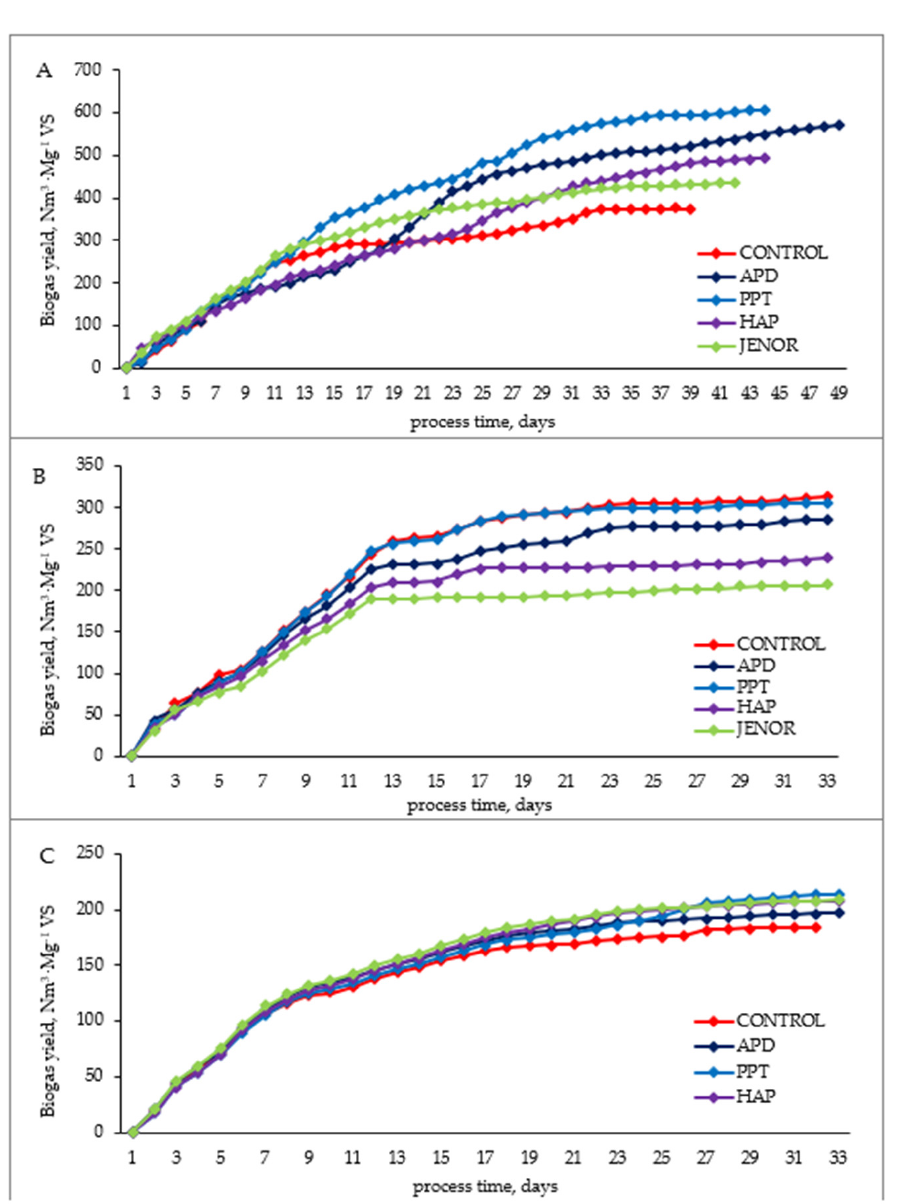
Figure 2. Cumulative biogas production from different types of silages: ( A ) maize silage, ( B ) grass silage, ( C ) igniscum silage. Table 2. Factorial variance in biogas and methane yields by substrate and enzyme